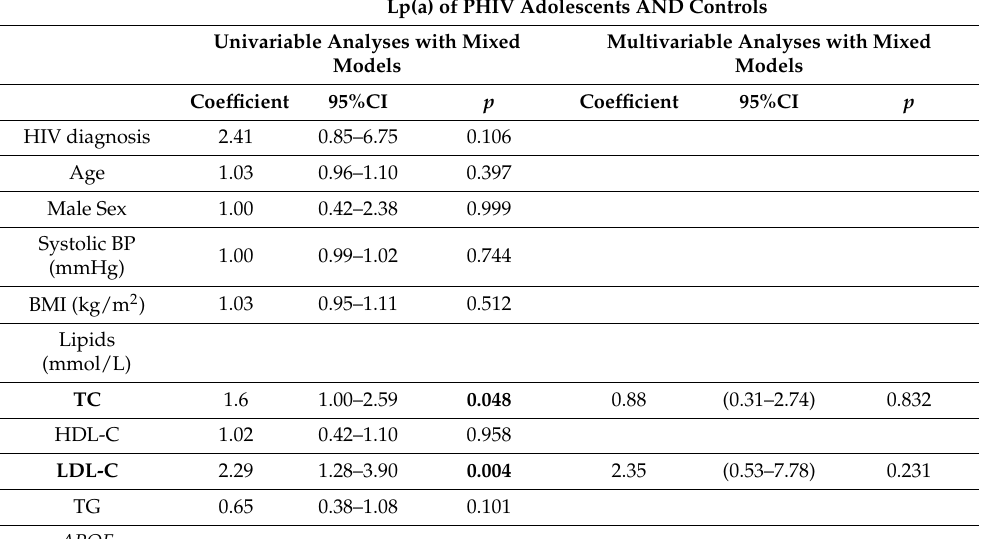
Table 4. Factors associated with Lp(a) in cohort